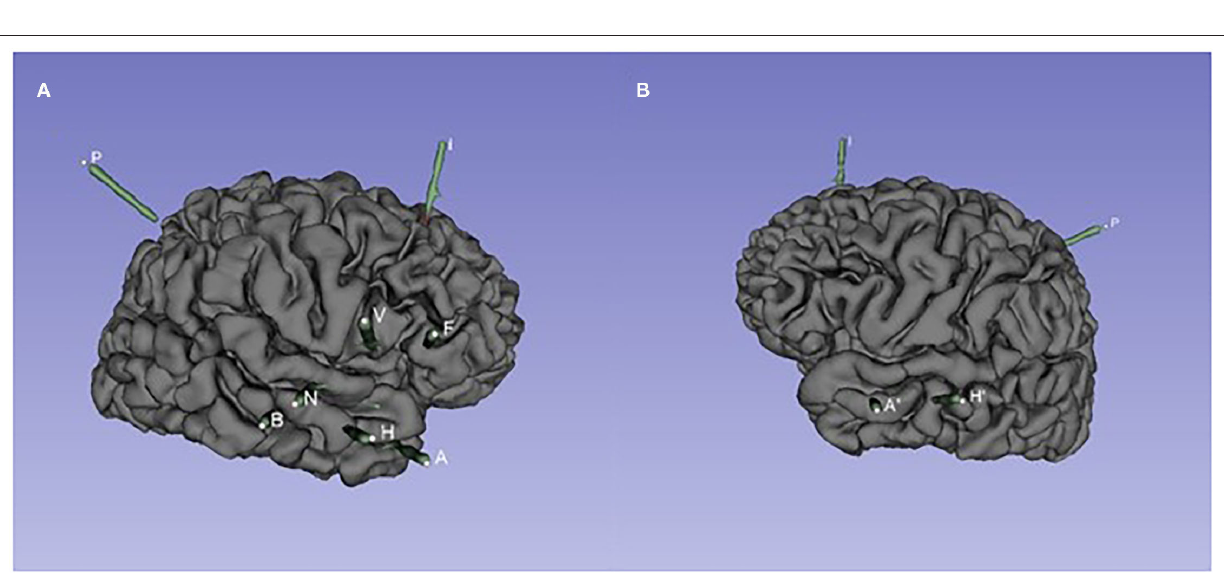
FIGURE 2 | The spatial position of SEEG electrodes of case 1. (A) Right hemisphere. Entry points to target points: A: the middle temporal gyrus to the amygdala; H: the middle temporal gyrus to the head of the hippocampus; B: the middle temporal gyrus to the middle of the hippocampus; N: the superior temporal gyrus to the posterior insular gyrus; V: opercular partis to the short gyri of insula; F: pars triangularis to anterior cingulated cortex; I: the middle frontal gyrus to the accessory gyrus; P: the supramarginal gyrus to the anterior insular gyrus. (B) Left hemisphere. Entry points to target points: A ′ : the middle temporal gyrus to the amygdala; H ′ : the middle temporal gyrus to the head of the